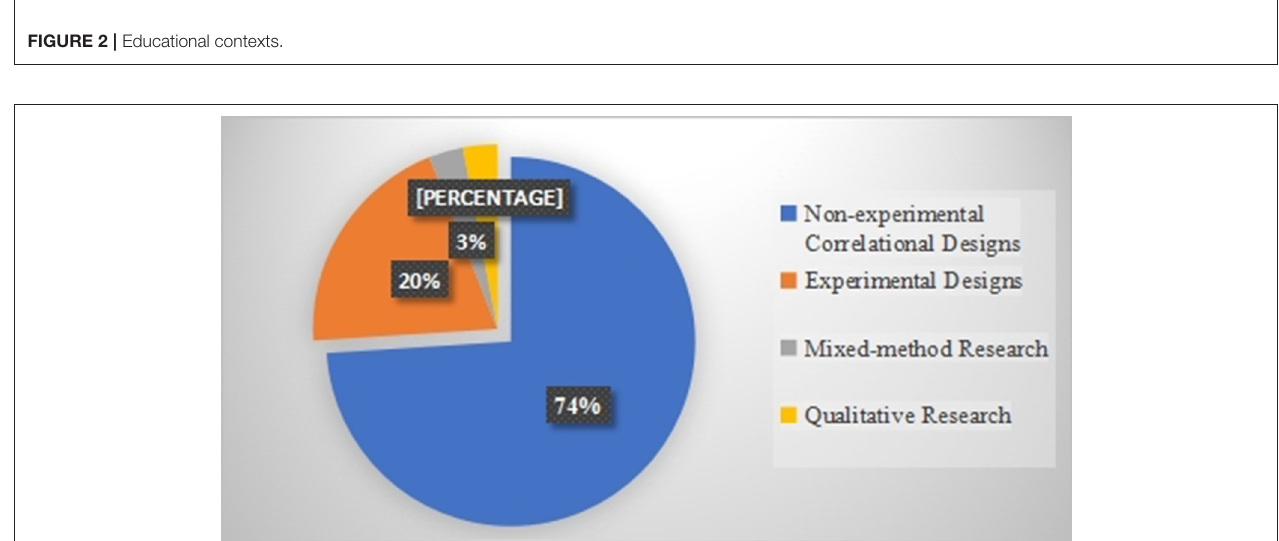
FIGURE 3 | Designs of the included